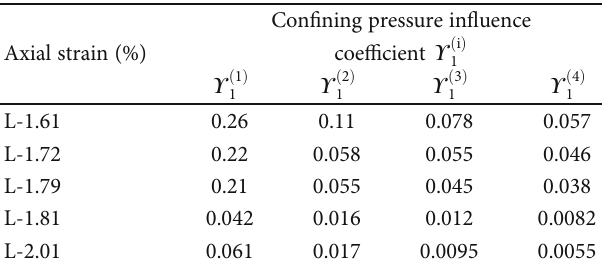
Table 12: The con fi ning pressure in fl uence coe ffi cient of nonwater specimen.